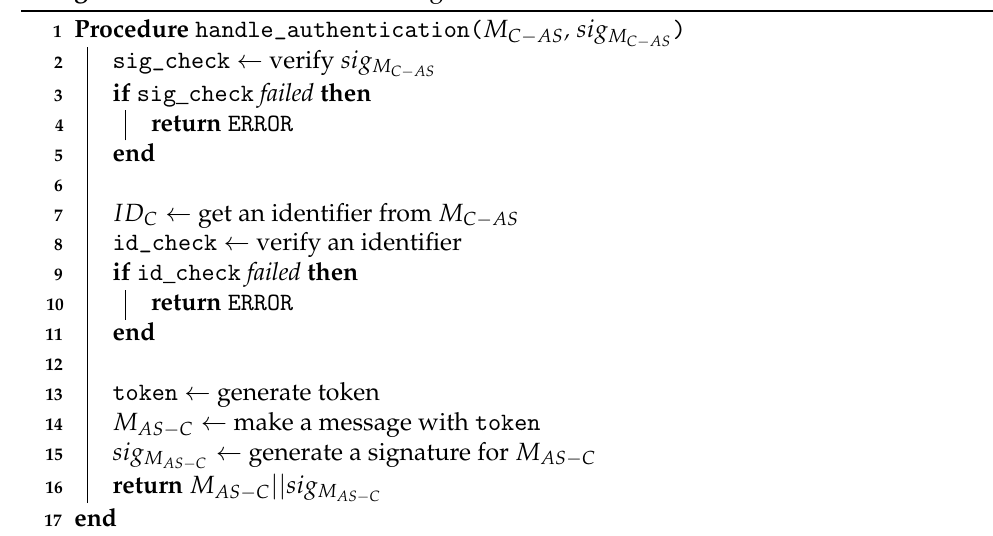
Algorithm 2: The authentication algorithm on the AS